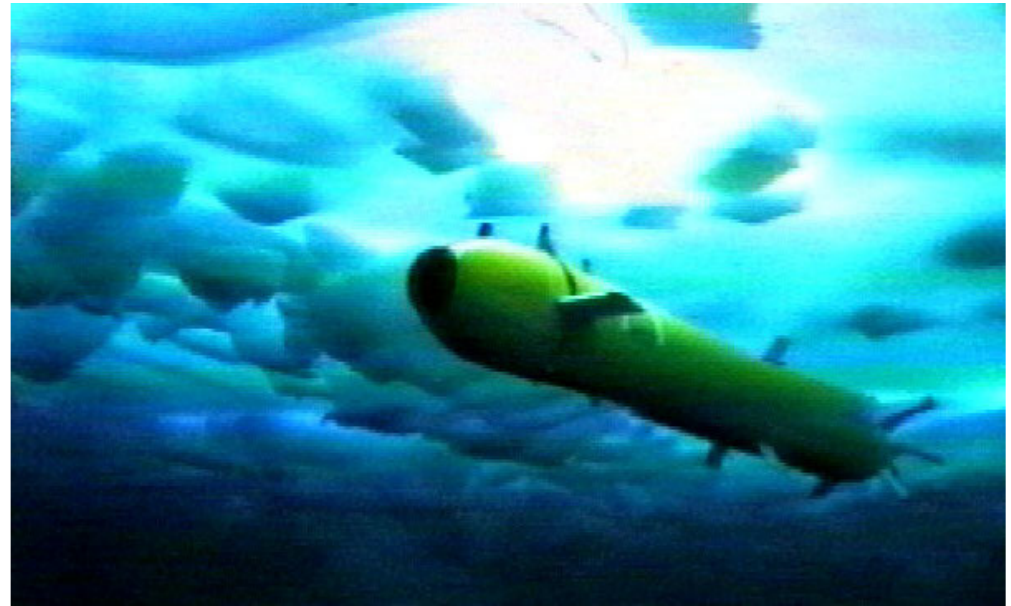
Figure 2. In 1992, the Theseus autonomous underwater vehicle (AUV) laid a fiber-optic cable from Ellesmere Island, Canada, to a remote sea ice camp 175 km from Ellesmere. Image Credit: International Submarine Engineering Ltd. Reproduced with